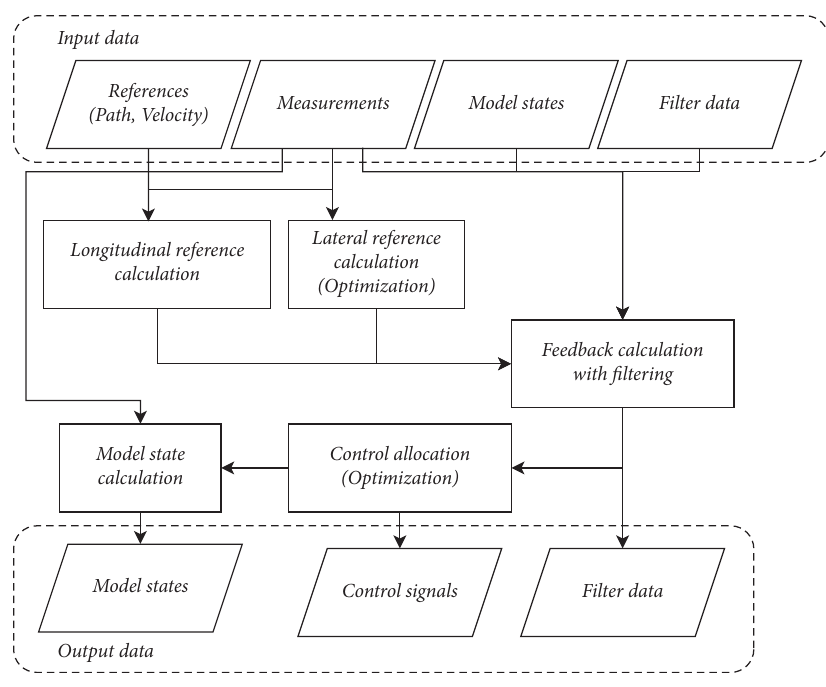
Figure 5: The control